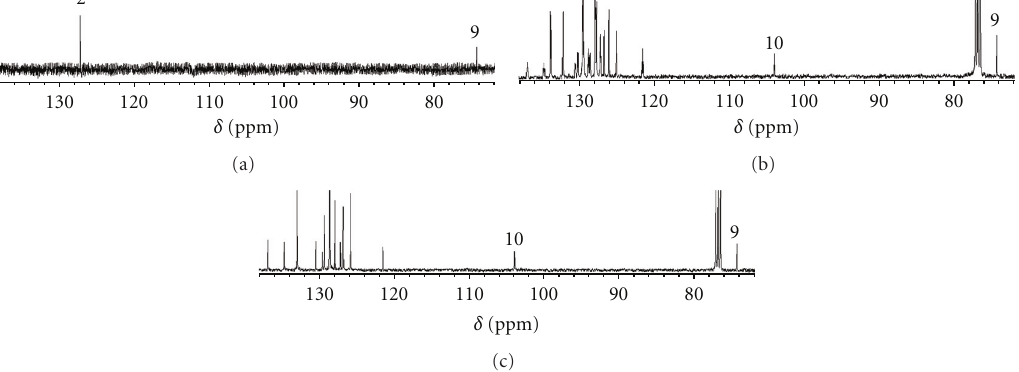
Figure 6: (a) Selective 1 H, 13 C-NOE di ff erence spectrum, (b) o ff -resonance decoupling spectrum, and (c) completely 1 H decoupled spectrum for 2e .